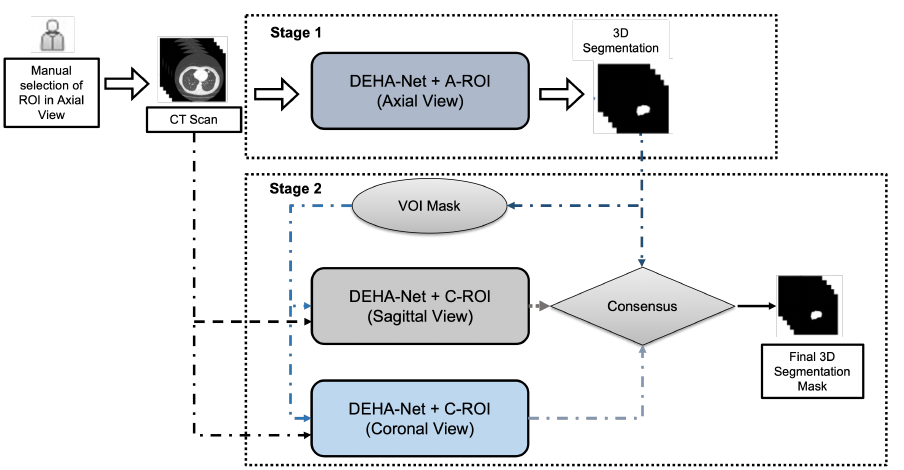
Figure 2. The proposed framework consists of two stages. In the first stage, the user or CADe system provides the ROI along the axial axis, and the DEHA -Net (dual-encoder-based hard attention network with self-hard attention) and adaptive ROI algorithm are used to determine the ROIs in the surrounding slices to perform the 3D segmentation. In the second stage, the sagittal and coronal views are created to segment the nodule. Finally, three segmentation predictions are fed into the consensus module to produce the final 3D segmentation mask.